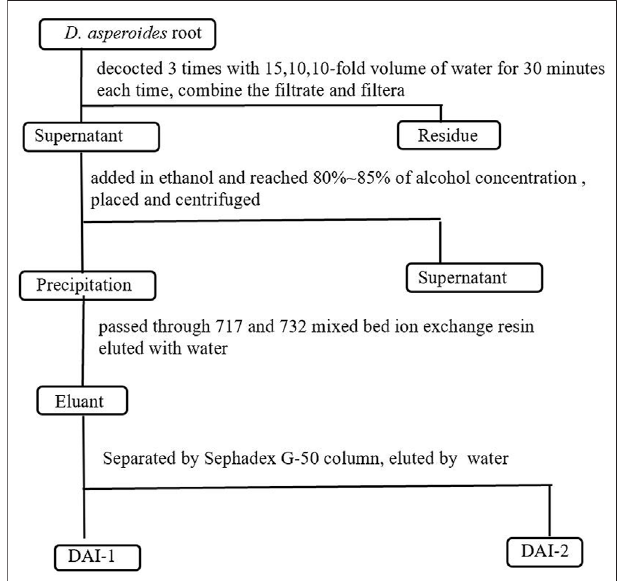
FIGURE 1 | Schematic of the process used for the extraction and isolation of D. asperoides